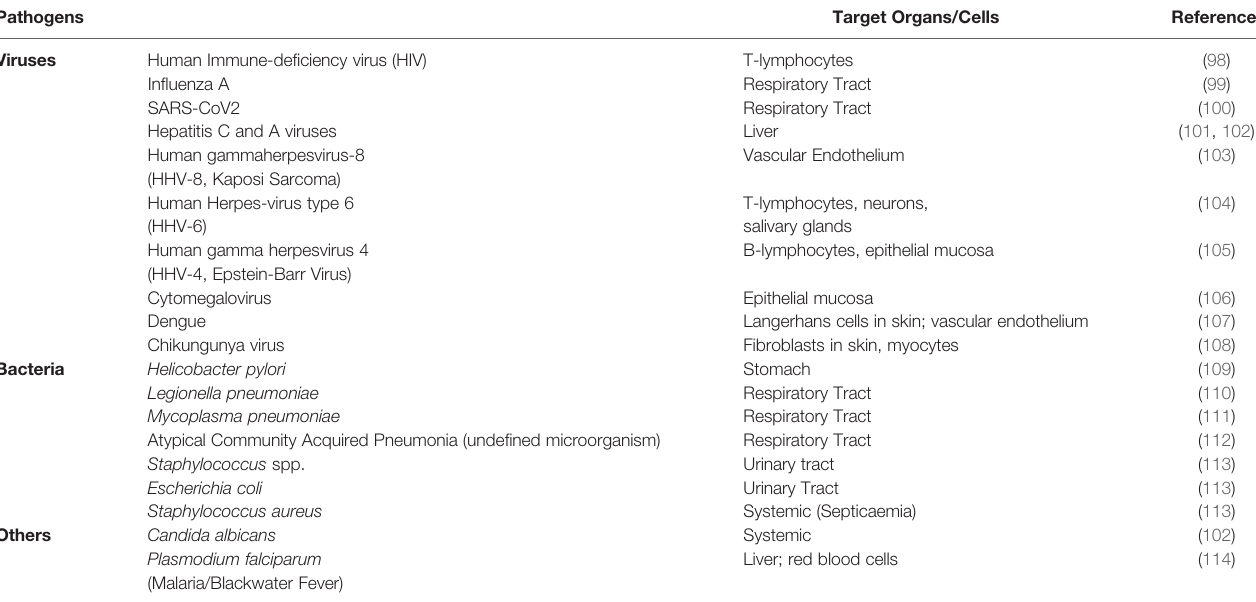
TABLE 2 | Pathogens associated with